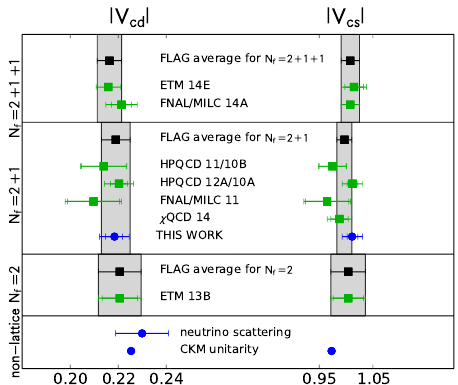
Figure 15 . Superposition of our results (blue circles) to the data presented in the most recent FLAG report [21]. The colour scheme of the remaining data points follows the FLAG convention, presented in detail in section 2 of ref [21]. The smaller error bars of our results show the lattice error only, whilst the large error bands include both, the theoretical and the experimental errors, added in